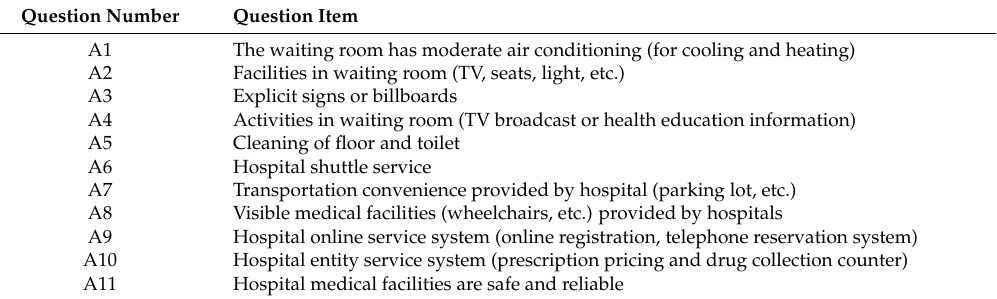
Table 12. Scale of medical structure service dimension.